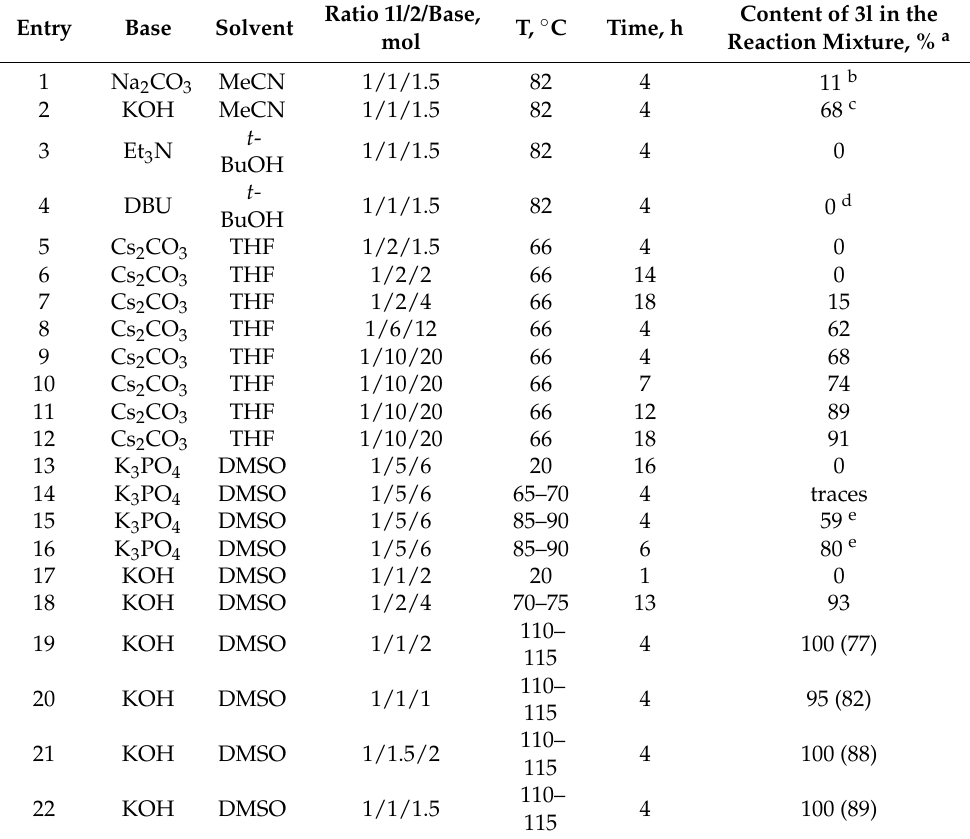
Table 1. Effect of reaction conditions on the synthesis of pyrrole–aminopyrimidine ensemble 3l